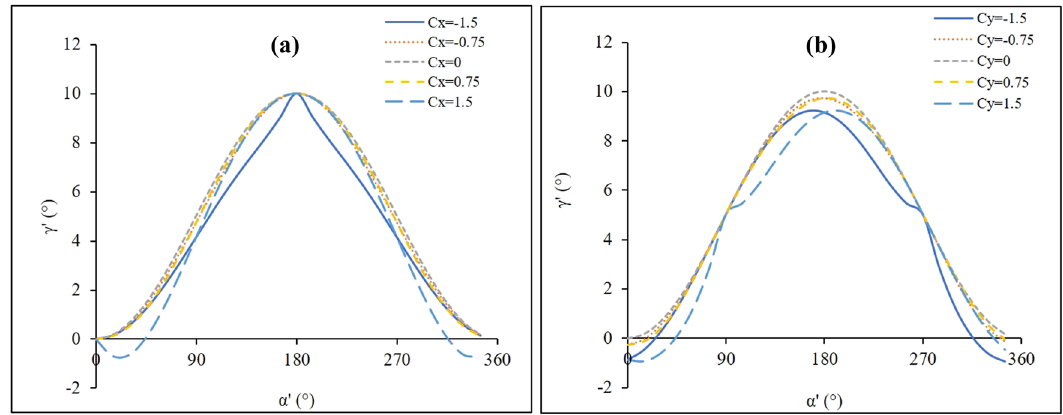
Figure 6: The in fl uence of ( a ) the vertex translation of the ppRPE/BM surface in X - axis ( C x ) and ( b ) the vertex translation of the ppRPE/BM surface in Y - axis ( C y ) on the ppRPE/BM layer angle γ ′ variation across the radial directions, with γ = 5°, β = 0°, and θ =